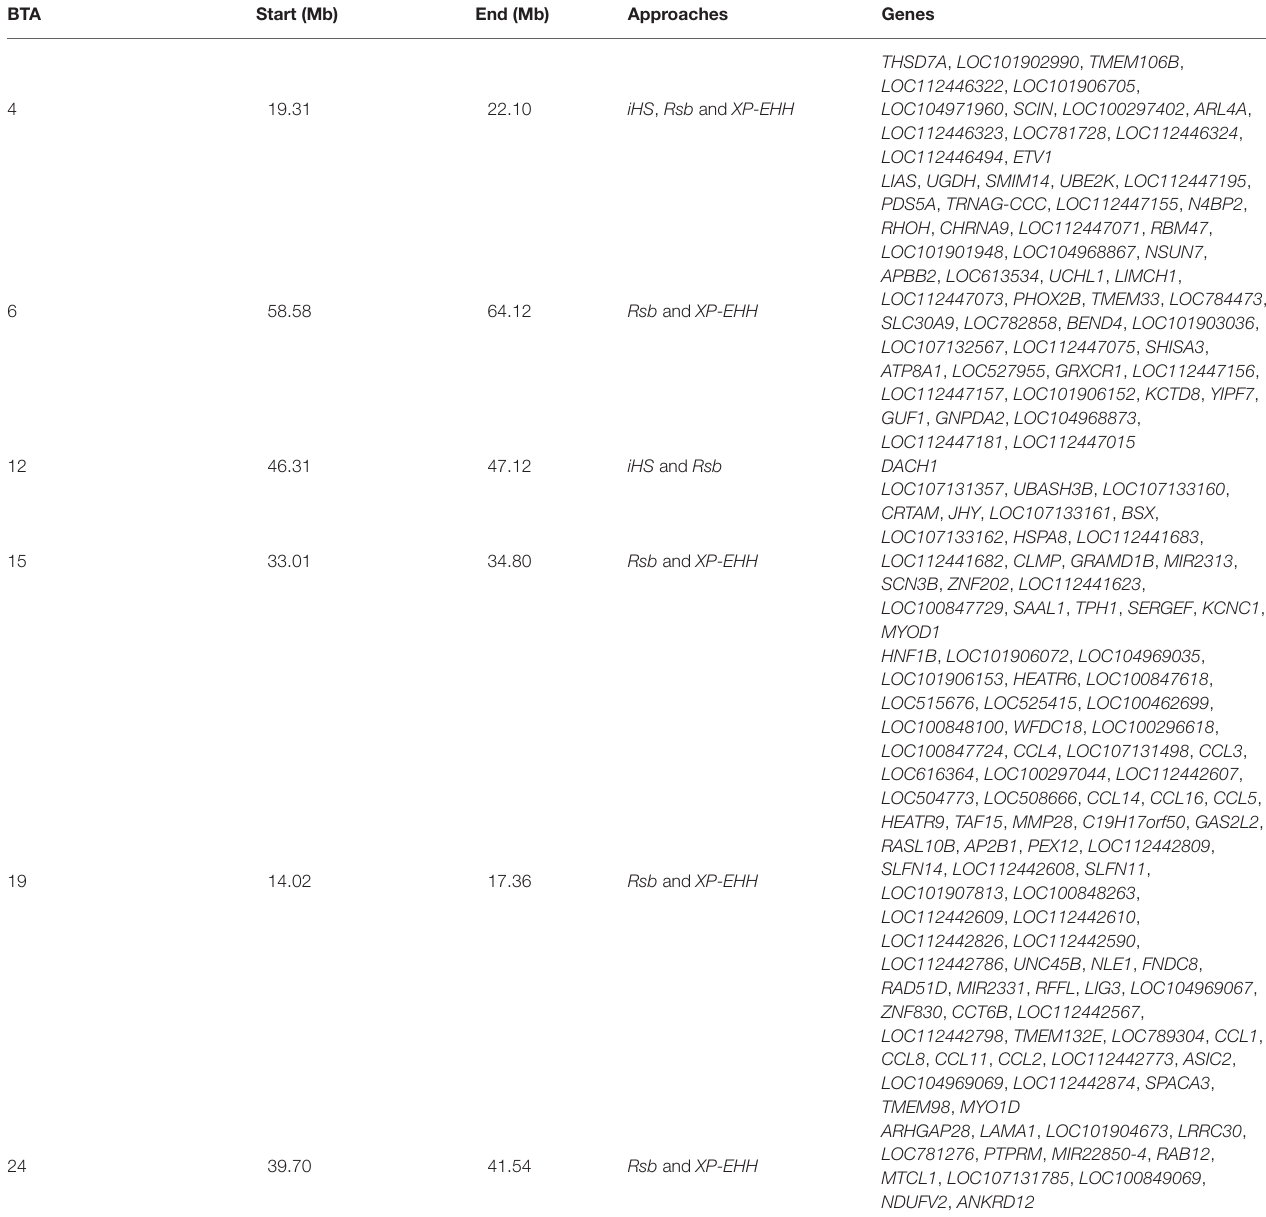
TABLE 1 | Overlapped genomic regions identified in at least two approaches in Maremmana cattle breed.